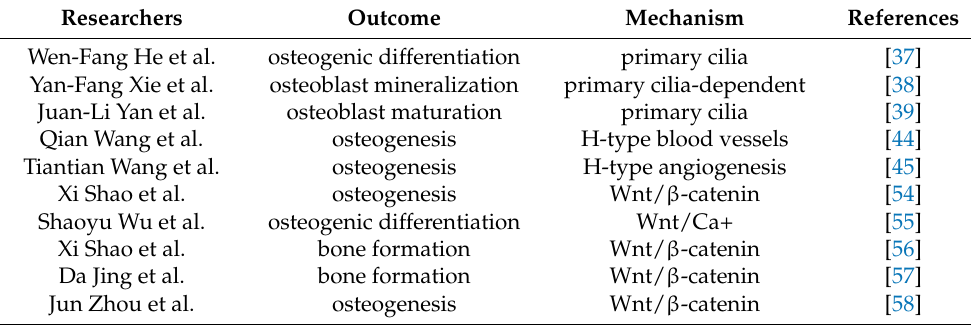
Table 2. The effects of a PEMF on osteogenesis and its mechanism.